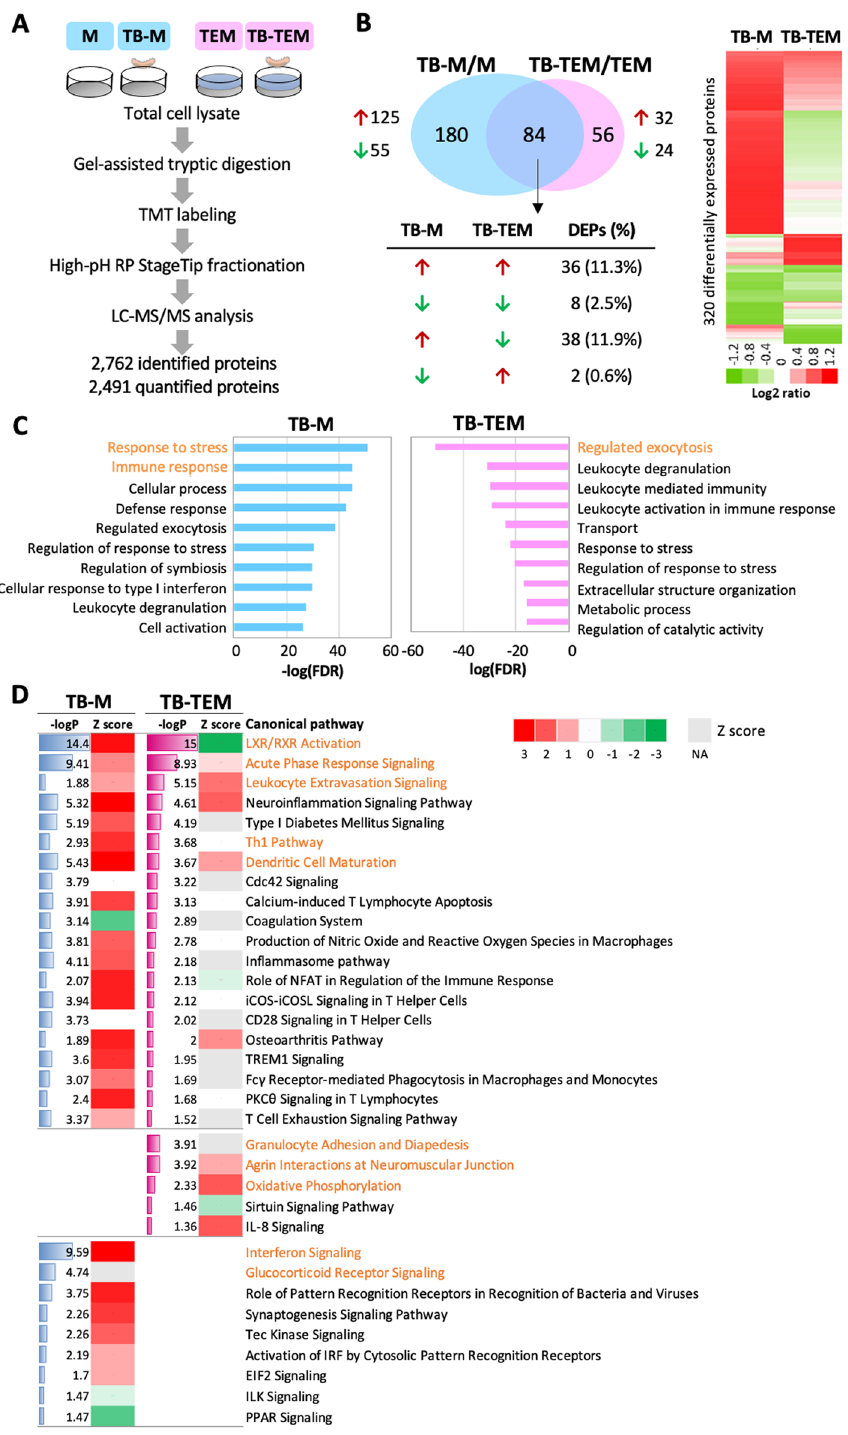
Figure 2. Differential proteomics profiles of heat-killed tuberculosis (HKTB)-stimulated classically activated macrophages (TB-Ms) and tumor-educated macrophages (TB-TEMs) with comparisons of Ms and TEMs. ( A ) Total cell lysates were collected for tandem mass tag (TMT)-based quantitative proteomics analysis to identify 2762 proteins, among which 2491 were quantified. ( B ) Overlap of differentially expressed proteins (DEPs) in the HKTB-stimulated M (TB-M) and TEM (TB-TEM) groups. ( C ) Enriched biological processes based on DEPs in the TB-M and TB-TEM groups using the Gene Ontology database. ( D ) Enriched pathways based on DEPs in the TB-M and TB-TEM groups using an Ingenuity Pathway Analysis (IPA). A z-score of > 0 indicates activation, while < 0 indicates inhibition of a cellular function or pathway. NA not available. Highlighted biological processes and pathways are marked in